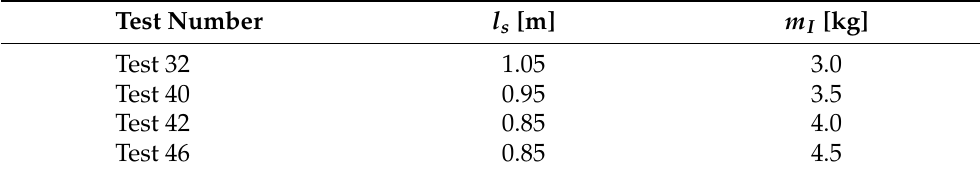
Table 2. The initial parameters of the four selected tests.